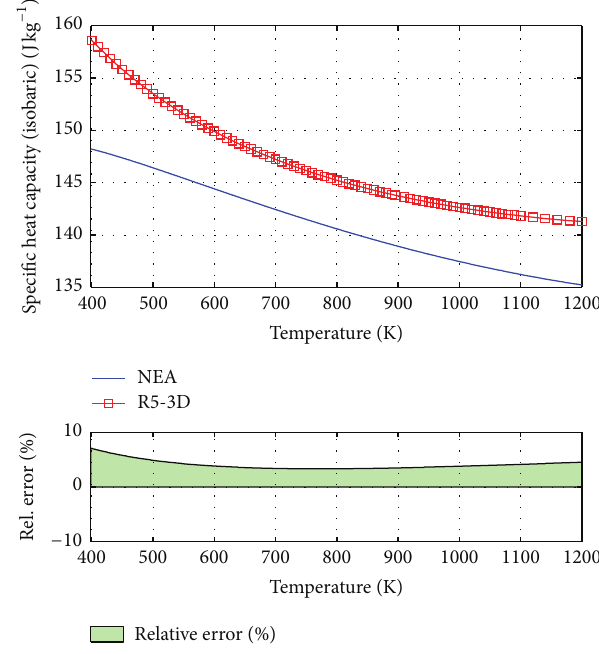
Figure2:LBEliquidspecificvolume,originalR5-3D“tpf”fileversus NEA report.